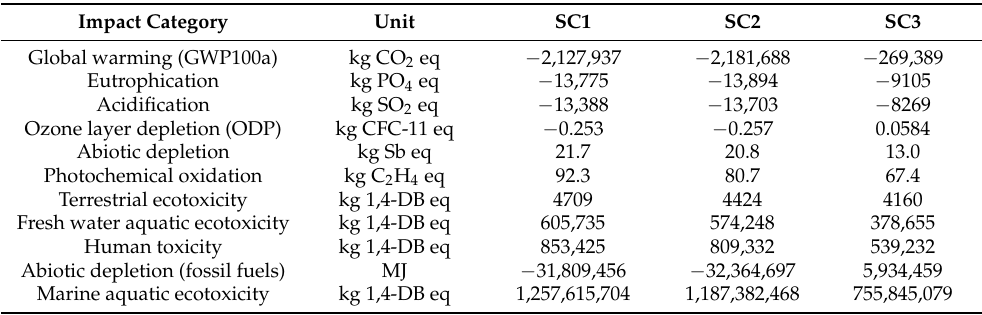
Table 6. Summary results per functional unit (farm with 1000 fattening pigs at farm gate)